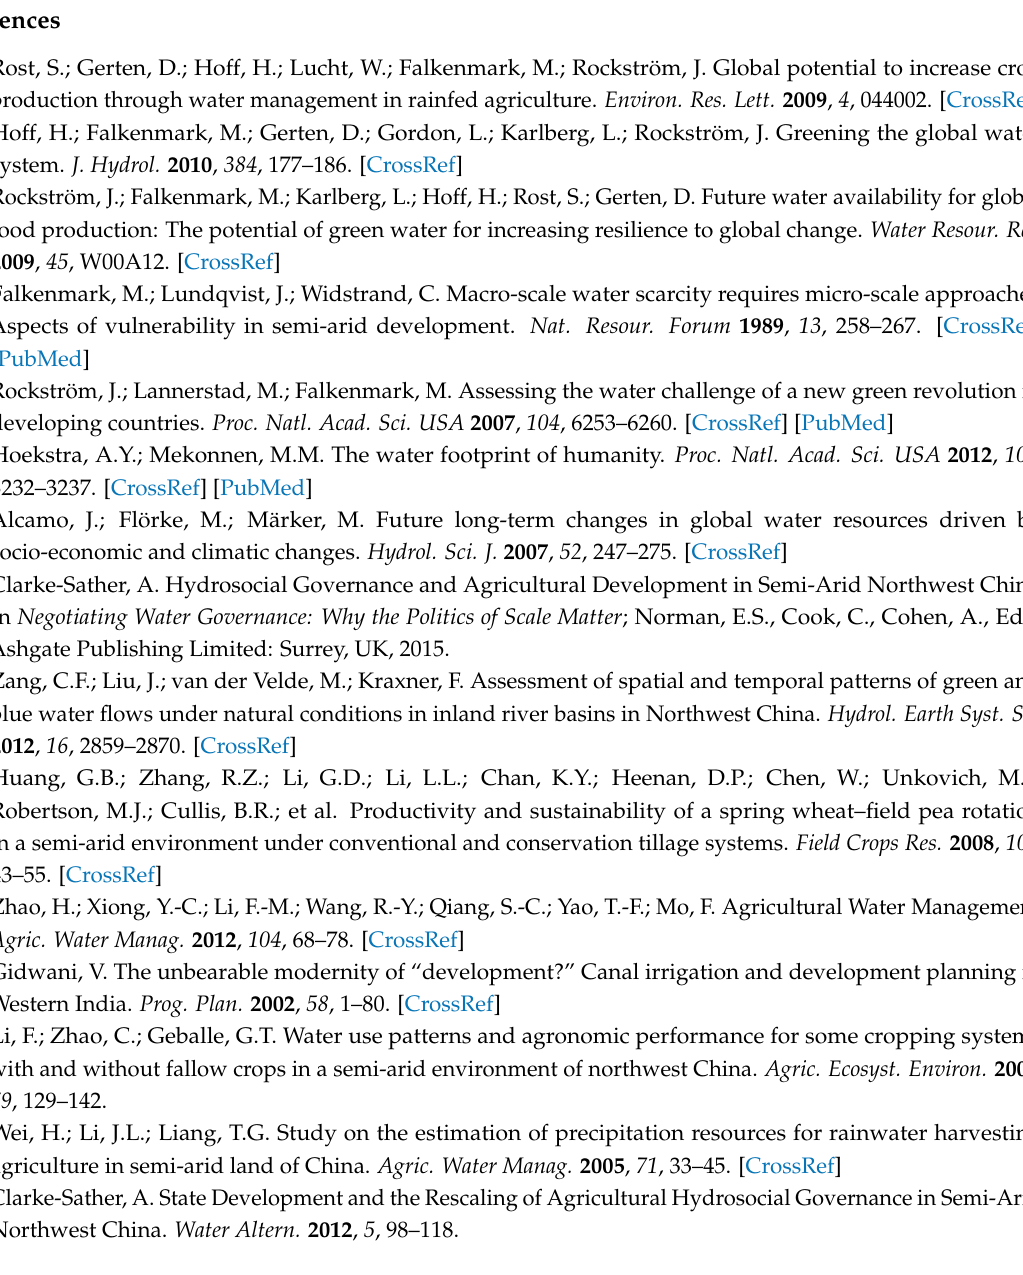
Table S1: Individual trials used to estimate the CWP averages presented in Table